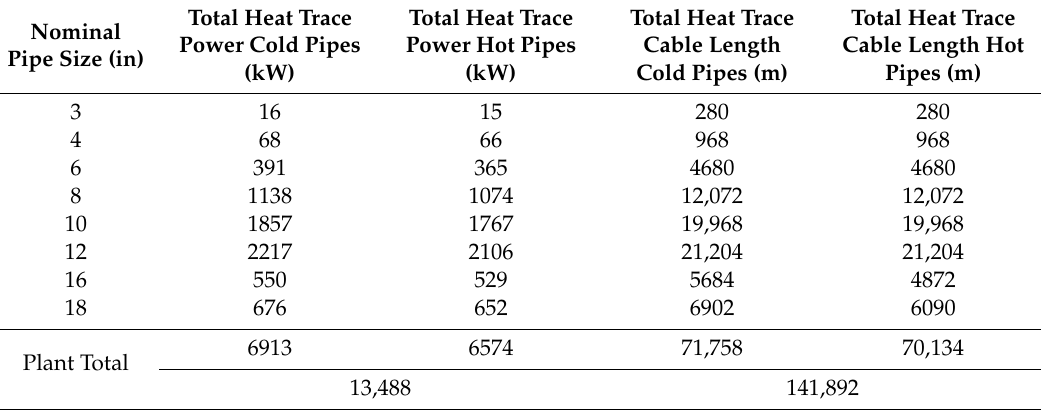
Table 4. Plant heat trace specifications for a HiTec-based plant with 388 collector loops.